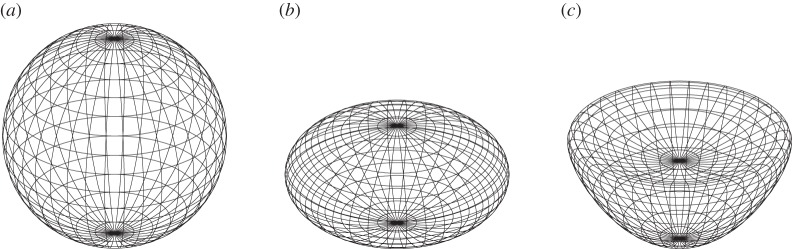
(a) A sphere, (b) an ellipsoid of revolution and (c) a bean-shaped surface with parameters a=0.6 and b=0.4; see (3.1) and (5.13). The three figures are from an orthographic perspective, viewed from 60° co-latitude and 15° longitude.